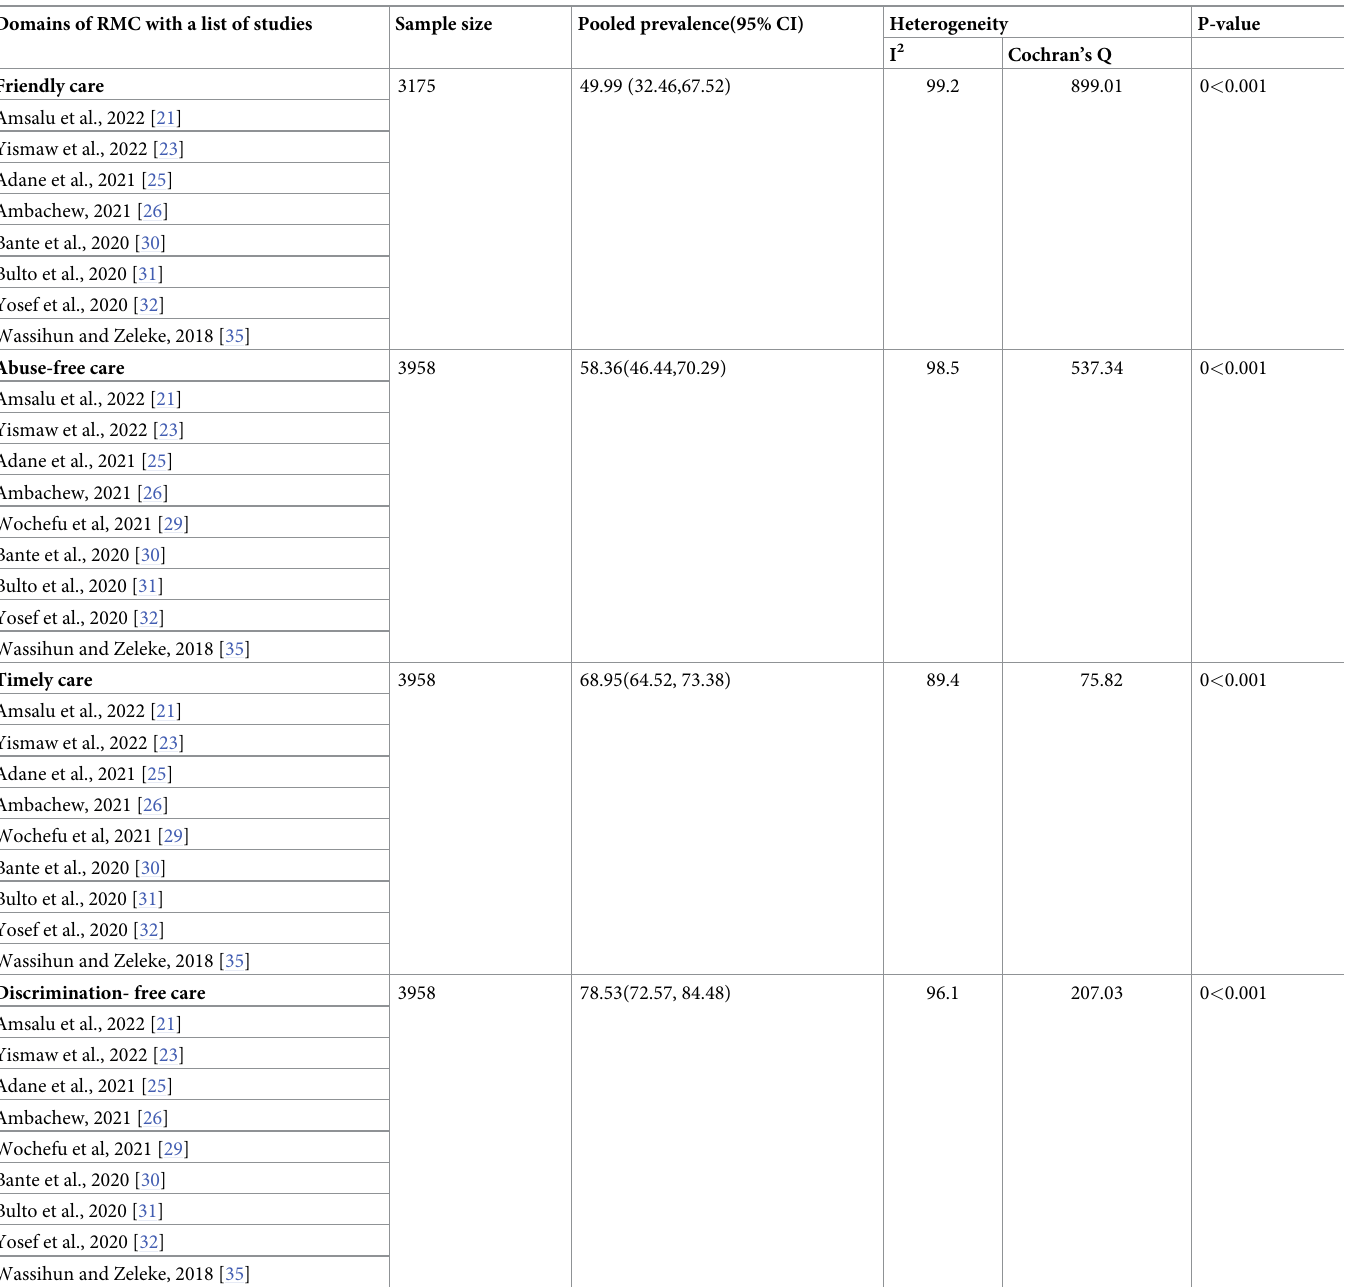
Table 2. The pooled prevalence of domains of RMC in Ethiopia,